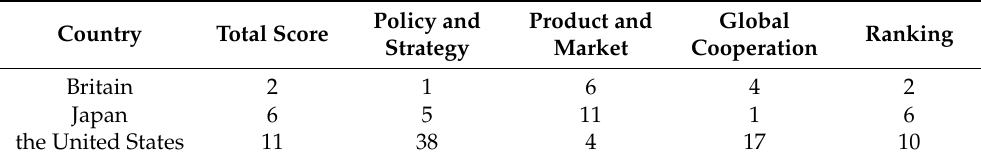
Policy and Product and Global Ranking Strategy Market Cooperation